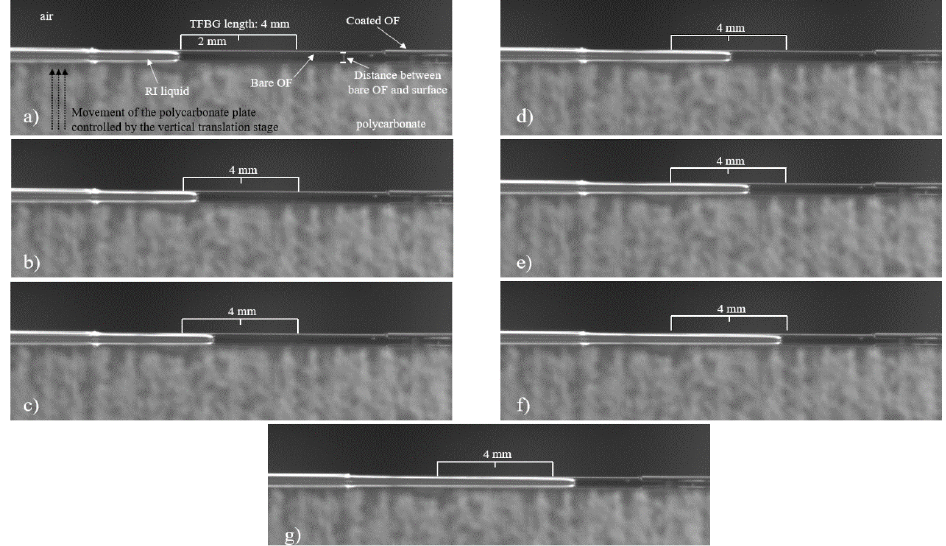
Figure 17. Frames sequence ( a – g ) during the gradual immersion of the TFBG sensor in a 1.46 RI